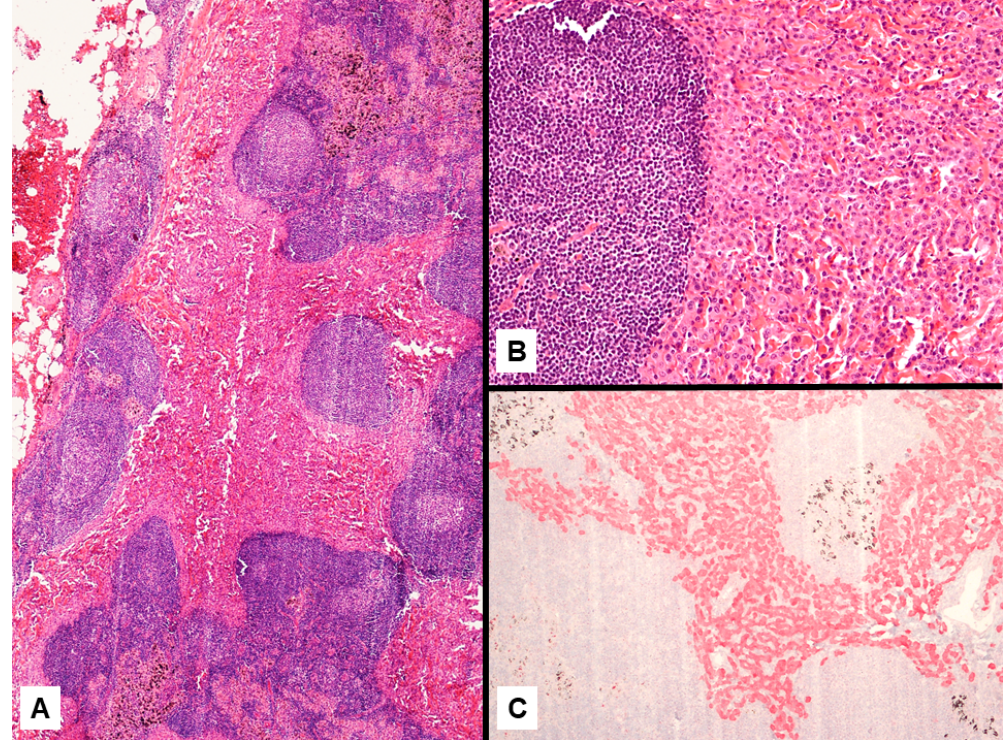
Figure 7. Epithelioid mesothelioma presenting as metastatic lymph node of the mediastinum ( A ) showing a solid prolif- eration of monomorphic epithelioid cells ( B ) strongly expressing calretinin ( C ).